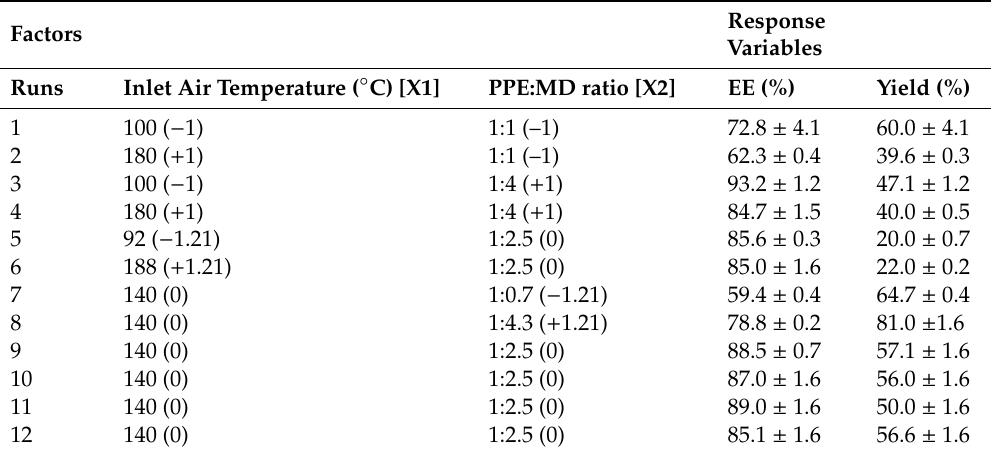
Table 2. Encapsulation e ffi ciency of anthocyanins (EE) and yield for the PPE microencapsulated by spray-drying according to the central composite